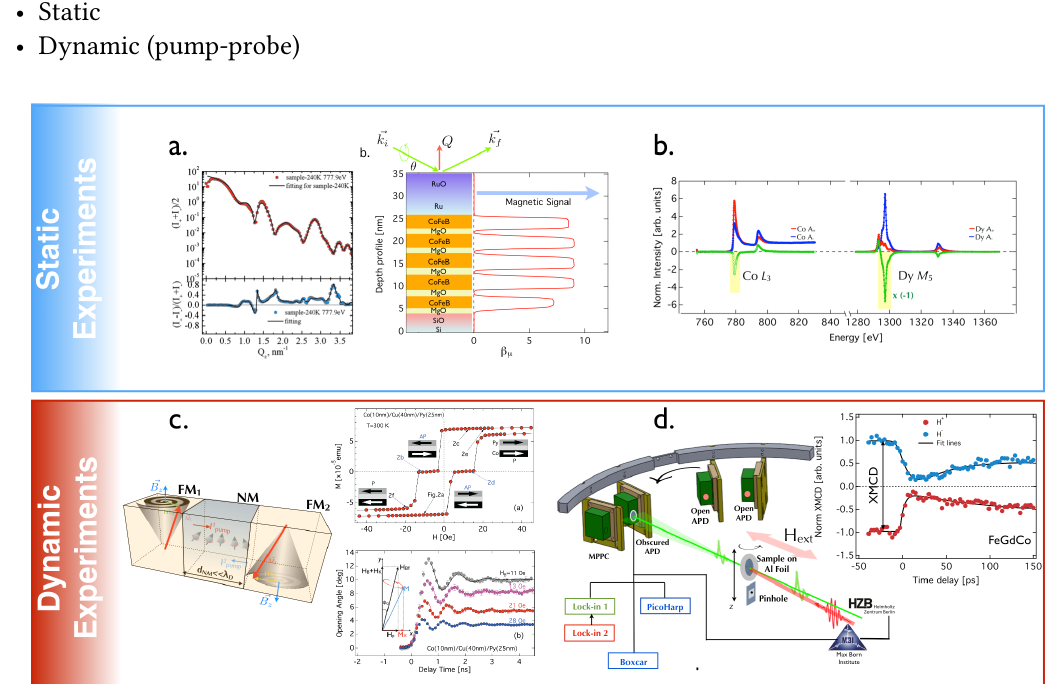
Figure 2: Static experiments consists in x-ray scattering on magnetic multilayers (a) or x-ray absorption spectroscopy in total electron yield or transmission geometry (b). Dynamic study of the magnetization precession in magnetic coupled layers (c) or laser pump x-ray probe experiments to study magnetization dynamics in magnetic alloys (d).